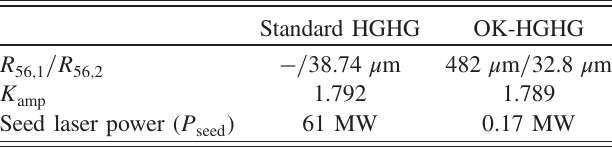
TABLE II. We list the simulation parameters optimized again for the time-dependent simulations, in addition to the parameters shown in Table